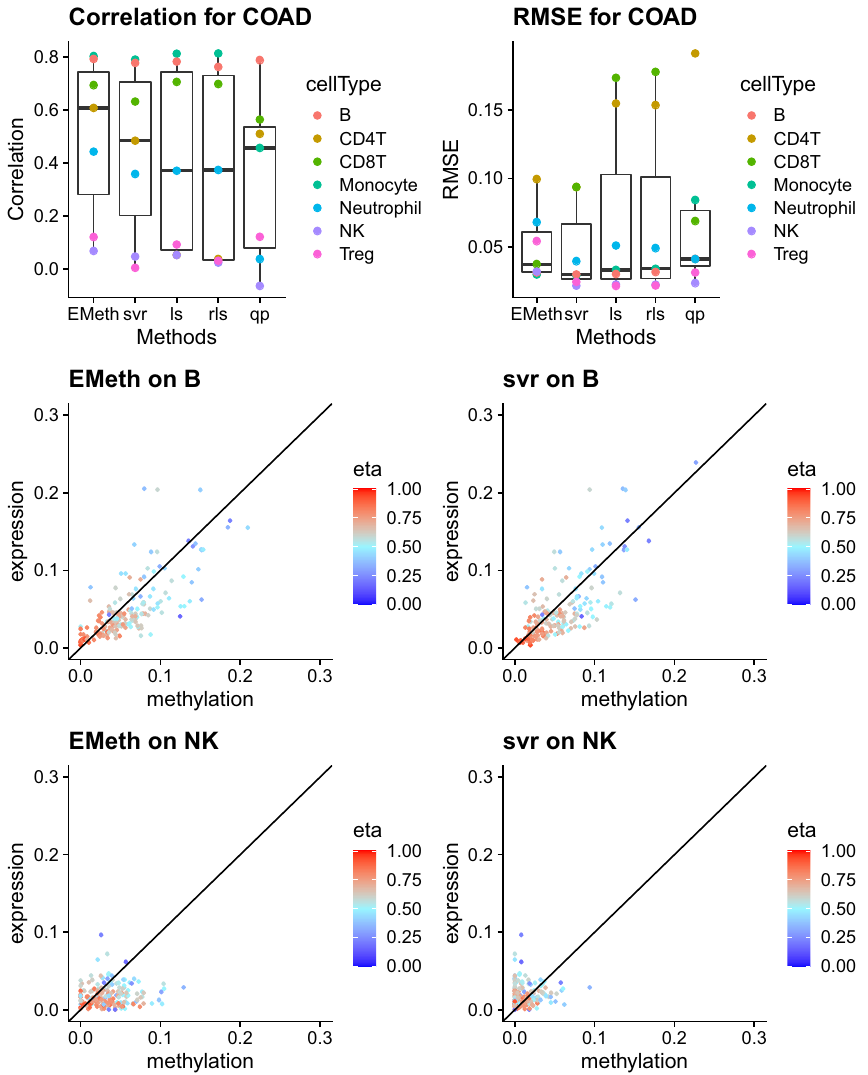
Figure 4. Compare cell type proportion estimates from colon cancer samples The top row illustrates the consistency (in terms of correlation and RMSE) between cell type proportion estimates from methylation data (by multiple methods) and gene expression data (by CIBERSORTx). The middle row displays the estimation result for B cells, an example where cell type proportion estimates from DNA methylation and gene expression are highly consistent. Each point corresponds to one tumor sample and it is colored by tumor purity (eta). The bottom row shows the results for natural killer cell, an example where cell type proportion estimates from DNA methylation and gene expression have very low correlations. These plots were generated using ggplot2 version 3.3.1 24